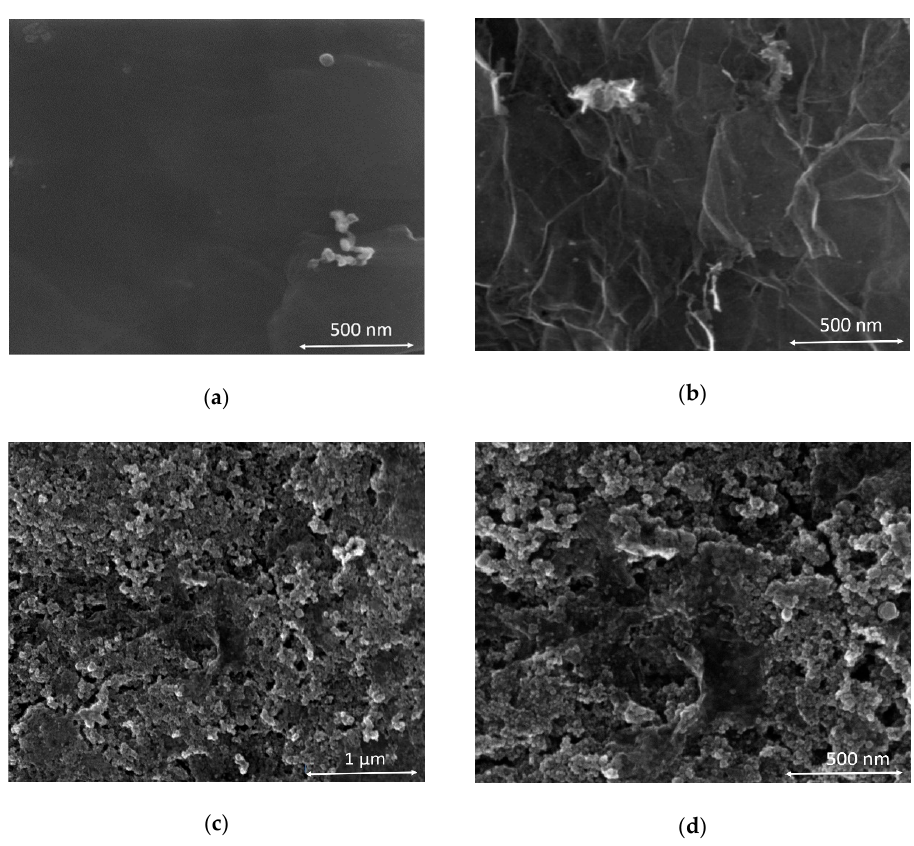
Figure 3. Structural and morphological characteristics of GO, bare LRGO, and LRGO/PDAC/ION- RGO electrodes: ( a ) SEM of GO at 500 nm, ( b ) LRGO at 500 nm, ( c ) modified electrode with RGO- IONs/PDAC at 1 µm, ( d ) 500 nm.